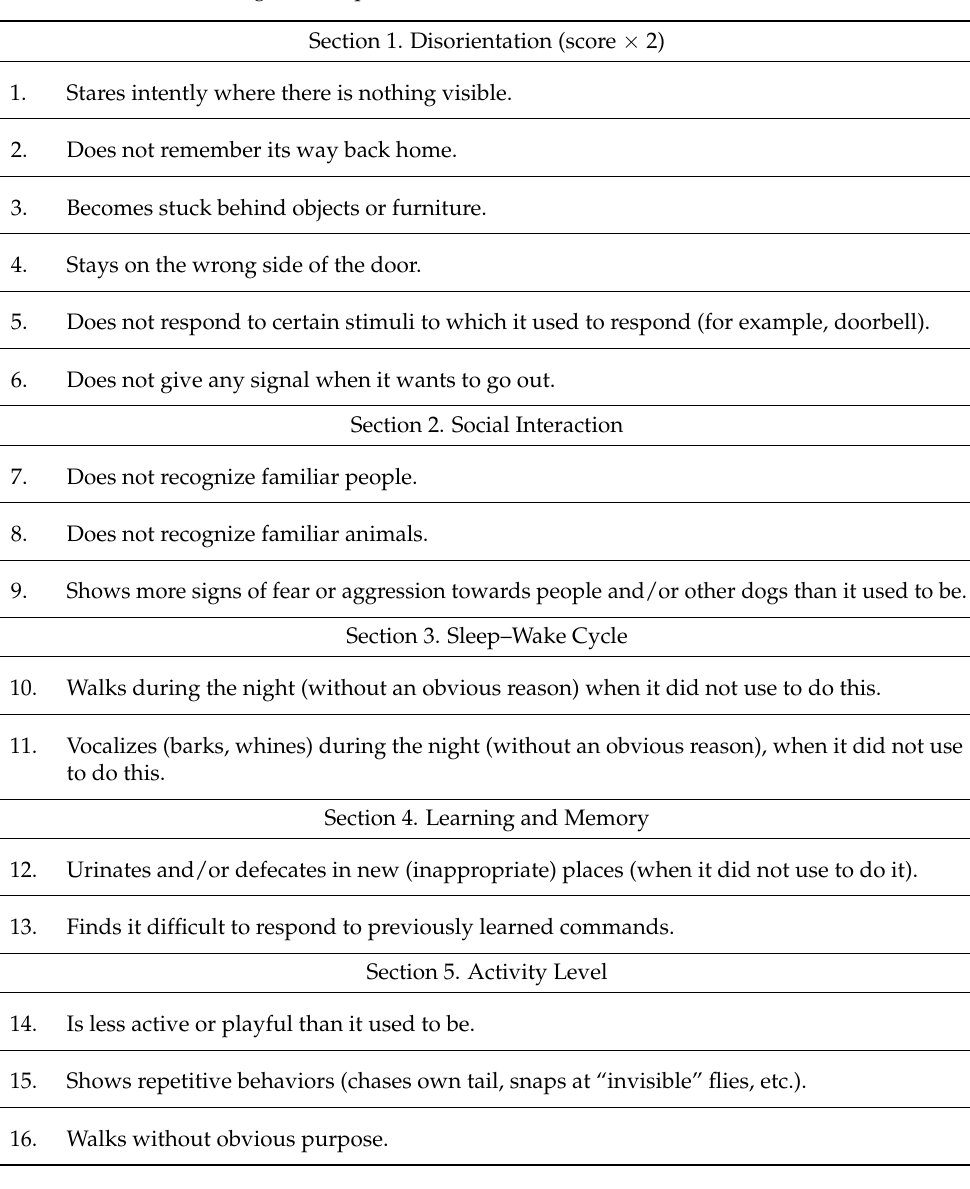
Table 2. Canine Cognitive Assessment Scale (CCAS). Frequency of the behavior observed: Never (0 point)–Once a month (1 point)–Once a week (2 points)–Almost every day (3 points). The scores of Section 1 sum twice. Clinical stage: Normal Ageing (score 0–7), Mild cognitive impairment (score 8–40) and Severe cognitive impairment (score